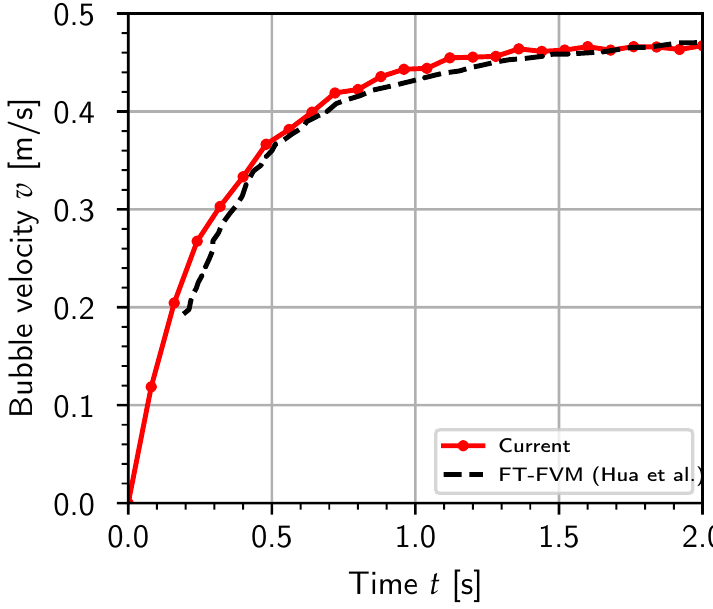
Figure 12. Bubble velocity evolution compared against the results of [3].